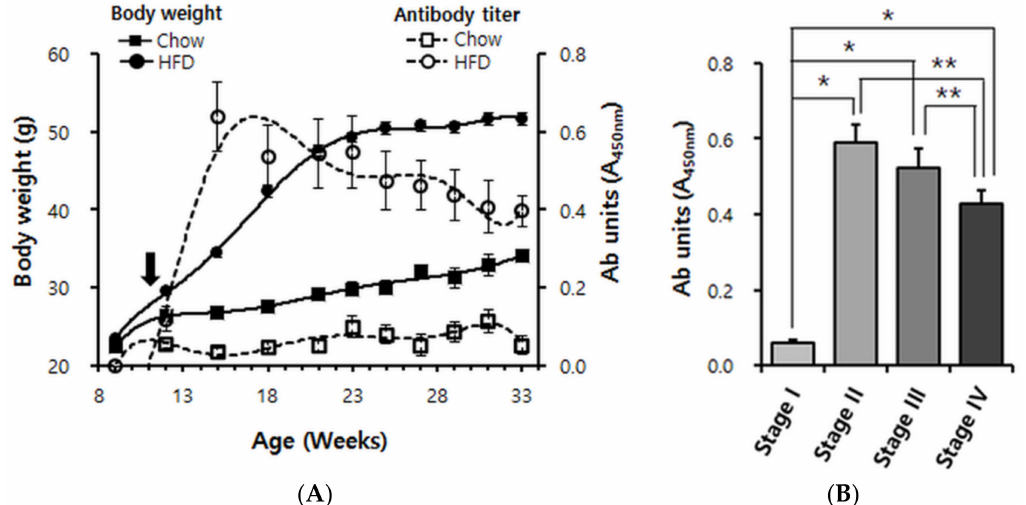
Figure 2. Longitudinal analysis of anti-pB1 antibody titers and body weight in Chow-fed and high fat diet (HFD)-fed mice. ( A ) Body weight curves and superimposition of autoantibody titer. Male C57BL/6 mice were continuously maintained on Chow ( n = 11; squares) or switched (black arrow) at 11 weeks of age to a 60% HFD ( n = 16; circles). Solid symbols indicate body weights; empty symbols indicate antibody units (absorbance of × 100 diluted serum at 450 nm). Data points are shown for every 3rd week, i.e., 9, 12, 15, 18, 21, 24, 27, 30 and 33 weeks of age. ( B ) Cluster analysis of the data shown in A. Based on the degree of obesity, its evolution was divided into four stages. Stage I: 9~12 weeks of age (overweight), stage II: 13~18 weeks of age (mildly obese), stage III: 19–25 weeks of age (moderately obese), stage IV: 26–33 weeks of age (severely obese). Error bars in panels A and B indicate means ± s.e.m. * p < 0.0001, ** p <